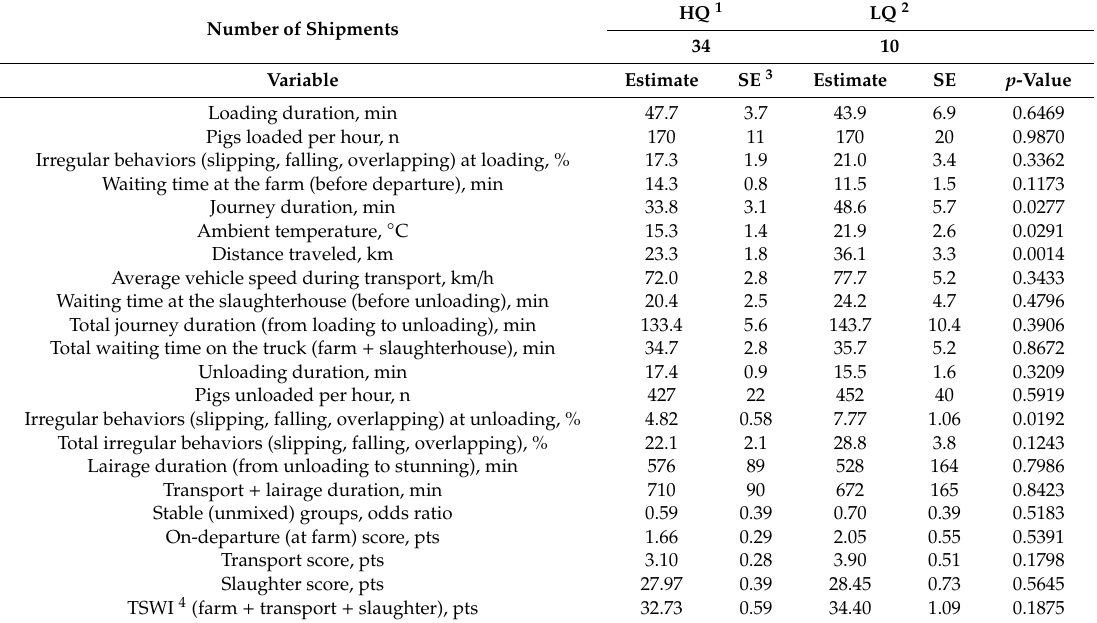
Table 2. Results of the linear mixed-model procedure to identify statistical di ff erences between the two clusters in the measured transport and slaughter